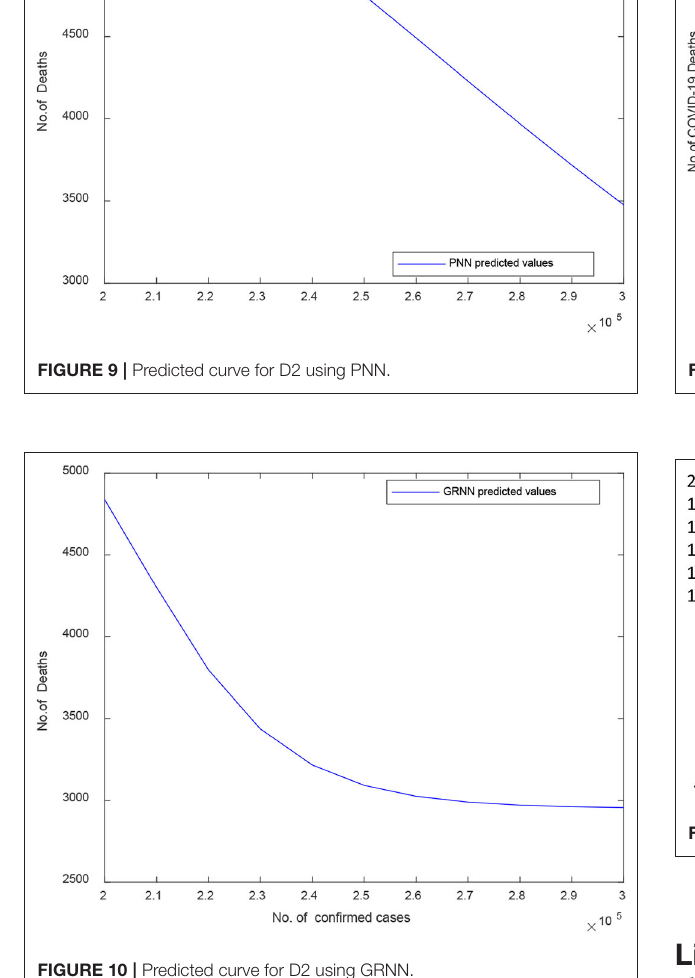
FIGURE 10 | Predicted curve for D2 using GRNN.